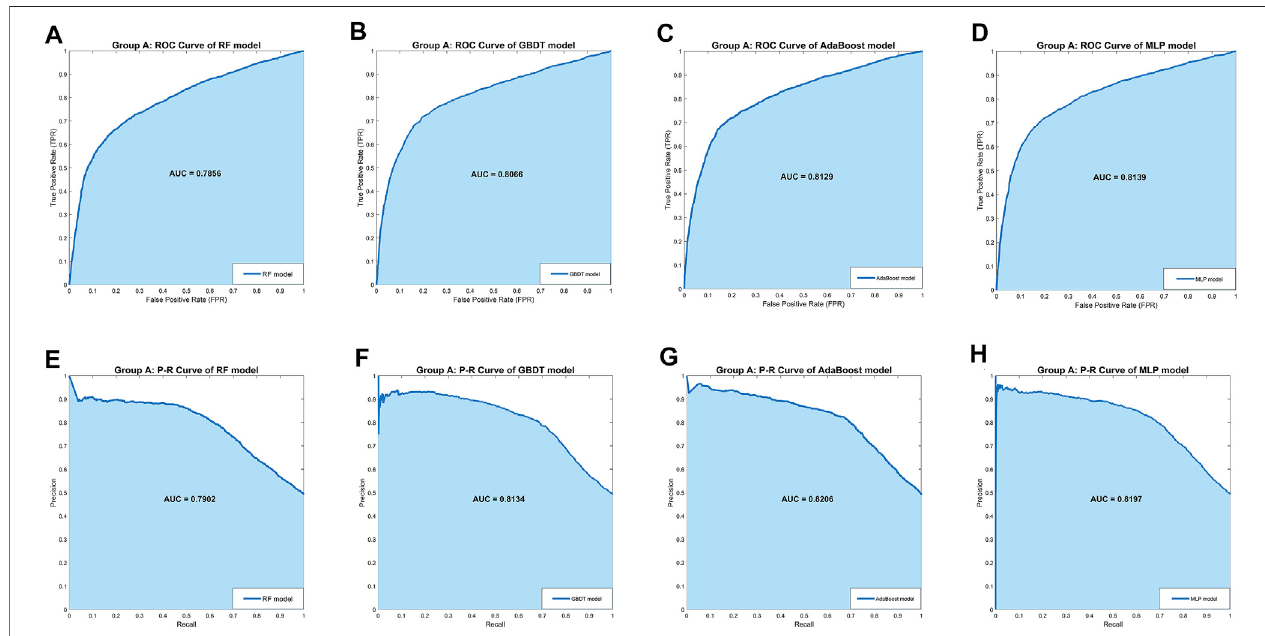
FIGURE2| TheROCcurvesandP-RcurvesofthefourmodelsinGroupA. (A – D) TheROCcurvesandAUCscoresoffourmodelsinGroupA:thedarkbluecurve refers to the ROC curve, the area under the curve is covered by light blue color and the AUC score is clearly marked. (E – H) The P-R curves and AUC scores of four models in Group A: the dark blue curve refers to the P-R curve, the area under the curve is covered by light blue color and the AUC score is clearly marked.